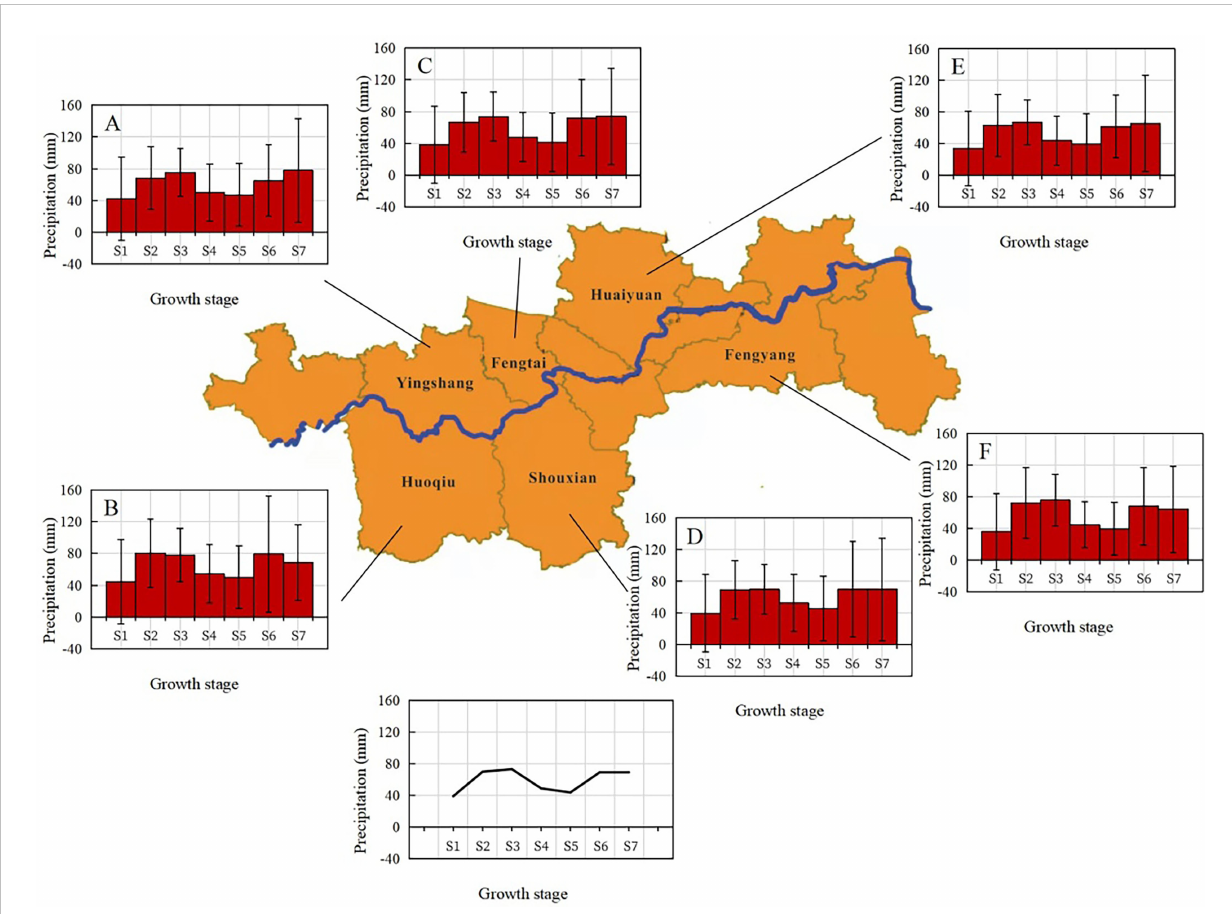
FIGURE 2 Average precipitation during wheat growth stages in ‘ Yanhuai ’ region i.e. (A) Yingshang, (B) Huoqiu, (C) Fengtai, (D) Shouxian, (E) Huaiyuan, and (F) Fengyang from 1999 to